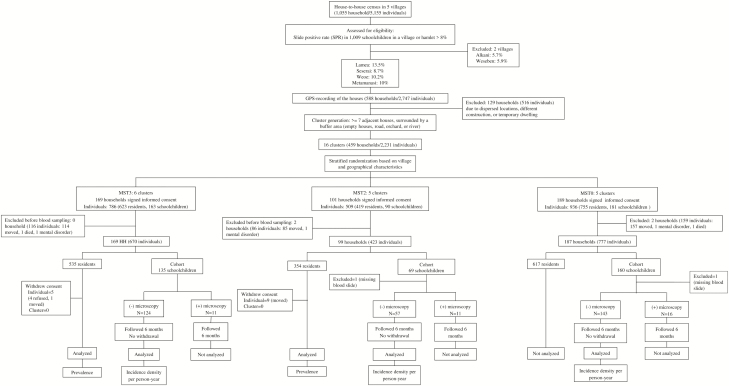
Trial profile. Abbreviations: GPS, Global Positioning System; MST, mass screening and treatment.